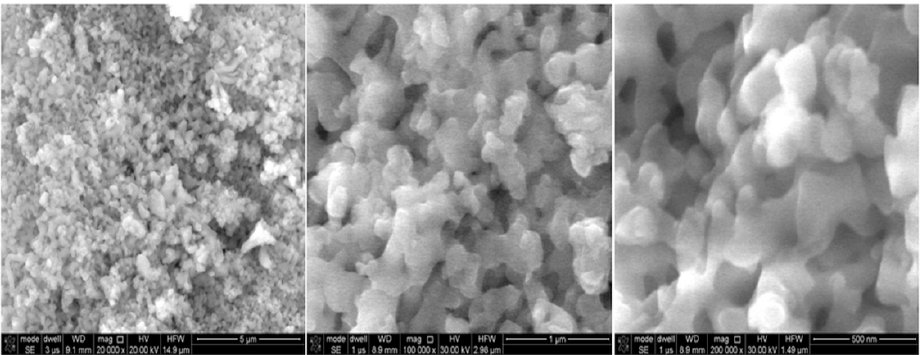
Figure 2. Picture of applied nanoparticles of ZnS:Mn + DBSA + CYS.